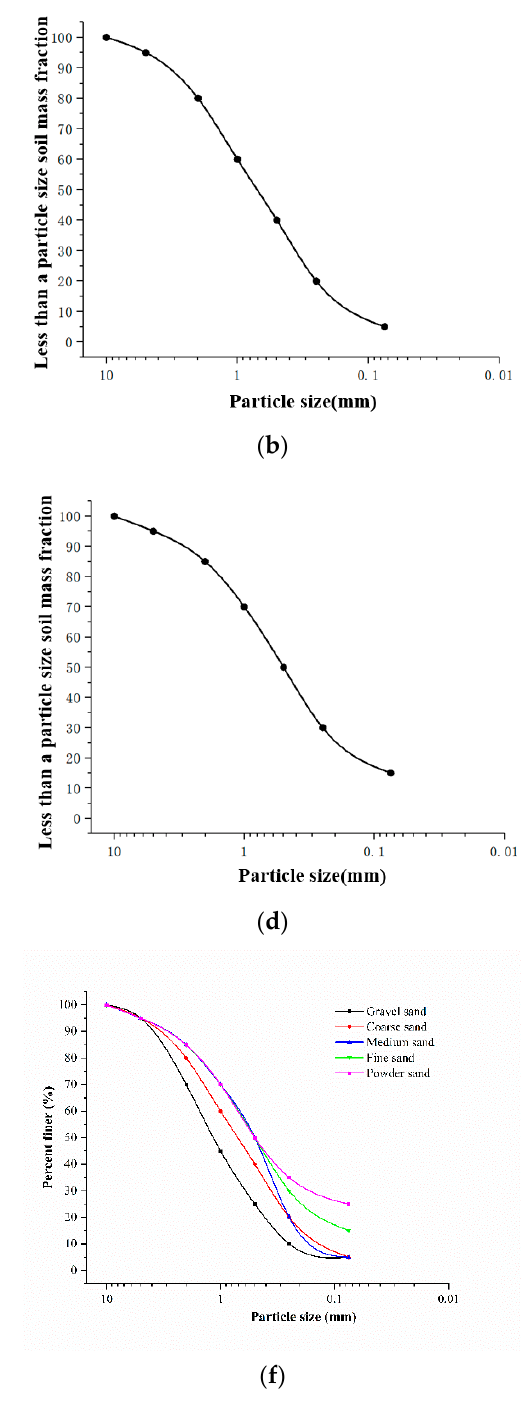
Figure 2. The particle gradation of different grain-size sand soil; ( a ) gravel sand; ( b ) coarse sand; ( c ) medium sand; ( d ) fine sand; ( e ) powder sand; and ( f ) comparison of five grain-size sand.